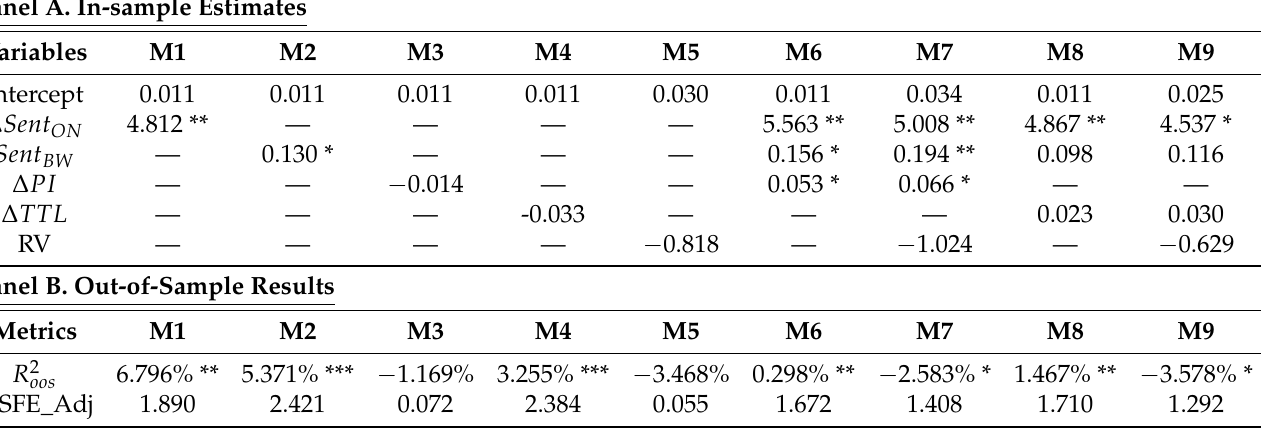
Table 7. Forecasting MCASI’s